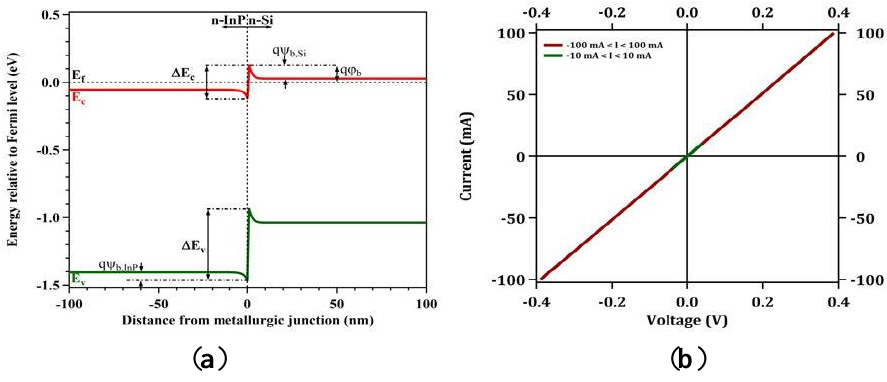
Figure 1. ( a ) Computed band diagram of the n-InP/n-Si heterojunction, ( b ) 4-points measurement of the I(V) characteristic of the hybrid